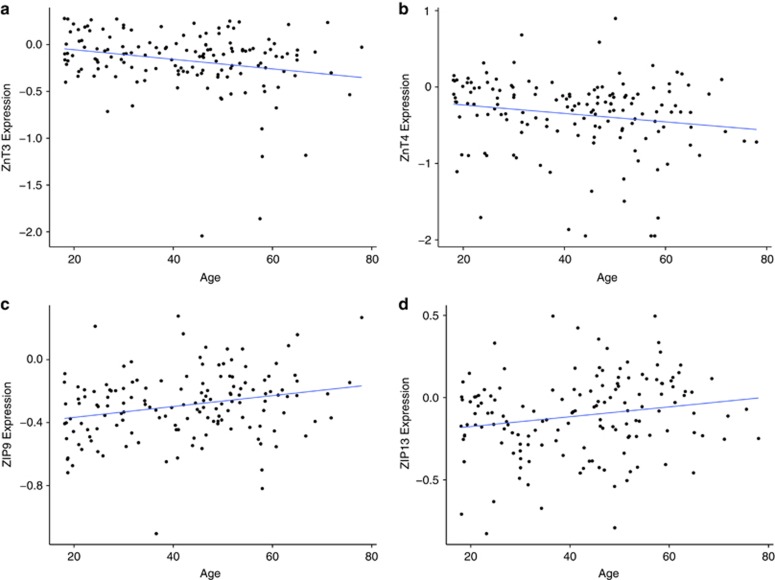
(a–d) On the x axis, Age (years) and on the y axis, there are mRNA expressions of ZNT3 (P<0.005) (a) and ZNT4 (P=0.038) (b), ZIP9 (P=0.0024) (c) and ZIP13 (P=0.0226) (d). Expression levels are measured as log2 of the ratio of sample signal to the reference signal. Each dot represents one individual. Line represents best-fitted line using regression.